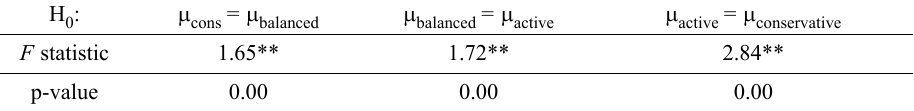
Table 12. Results of variance hypothesis testing across 3 fund